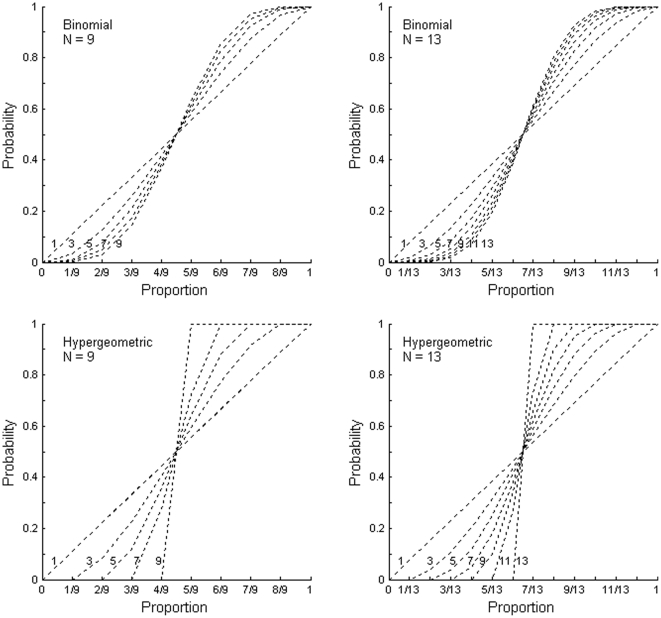
All possible theoretical models.All possible theoretical models corresponding to binomial (binK) or hypergeometric (hypK) distributions with the length of trials K.